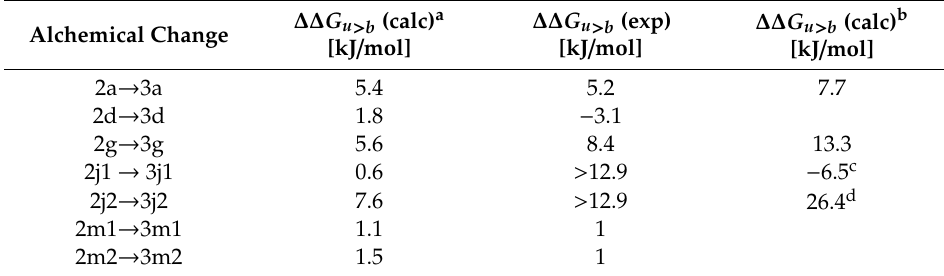
Table 2. Relative Binding Free Energies between the 2 and 3